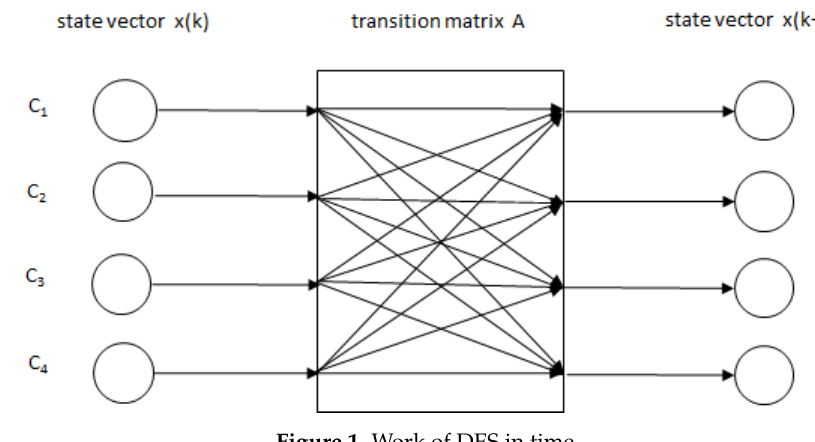
Figure 1. Work of DES in